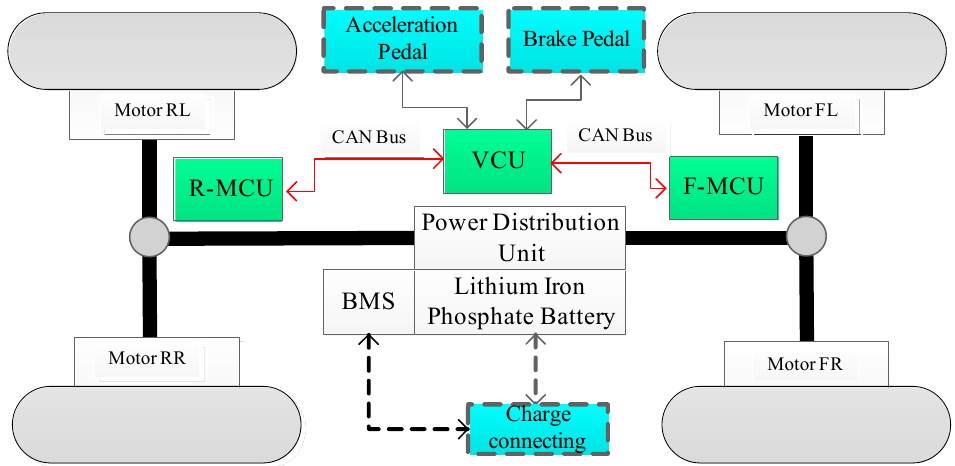
Figure 4. Configuration of PHEV test platform distribution.